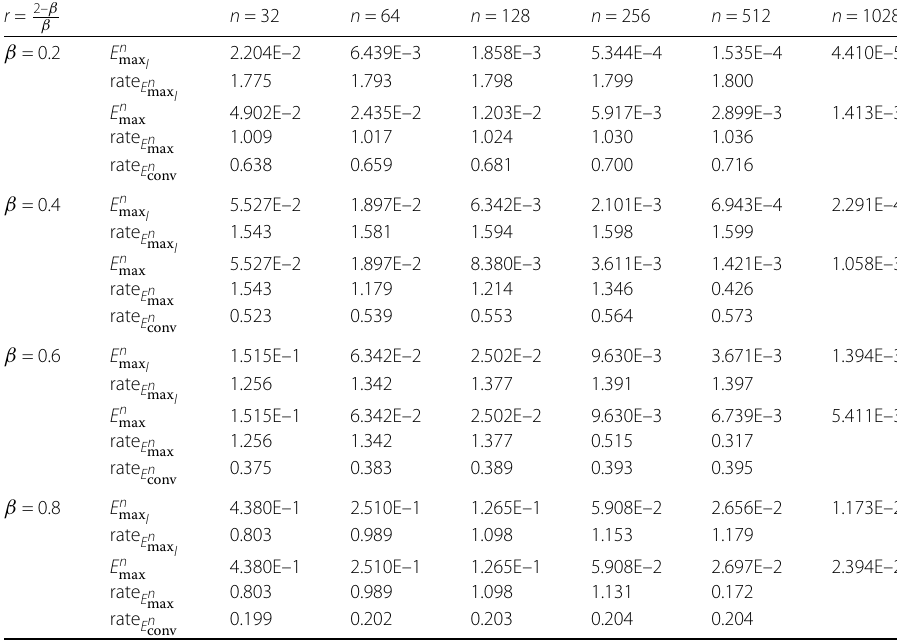
Table 2 Errors and order convergence for u 2, β ex using using (41) with r = 2– β r = 2– β β n =